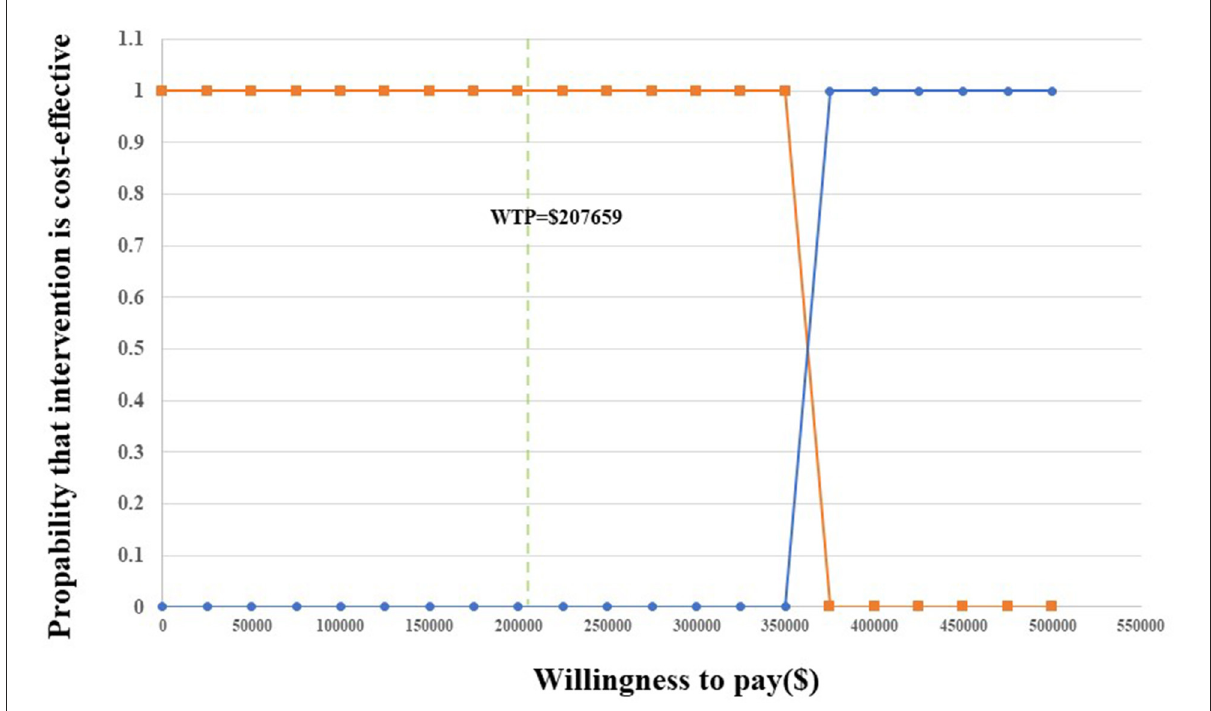
FIGURE2 Acceptability curves for the choice of nivolumab plus ipilimumab vs. chemotherapy at different WTP thresholds.